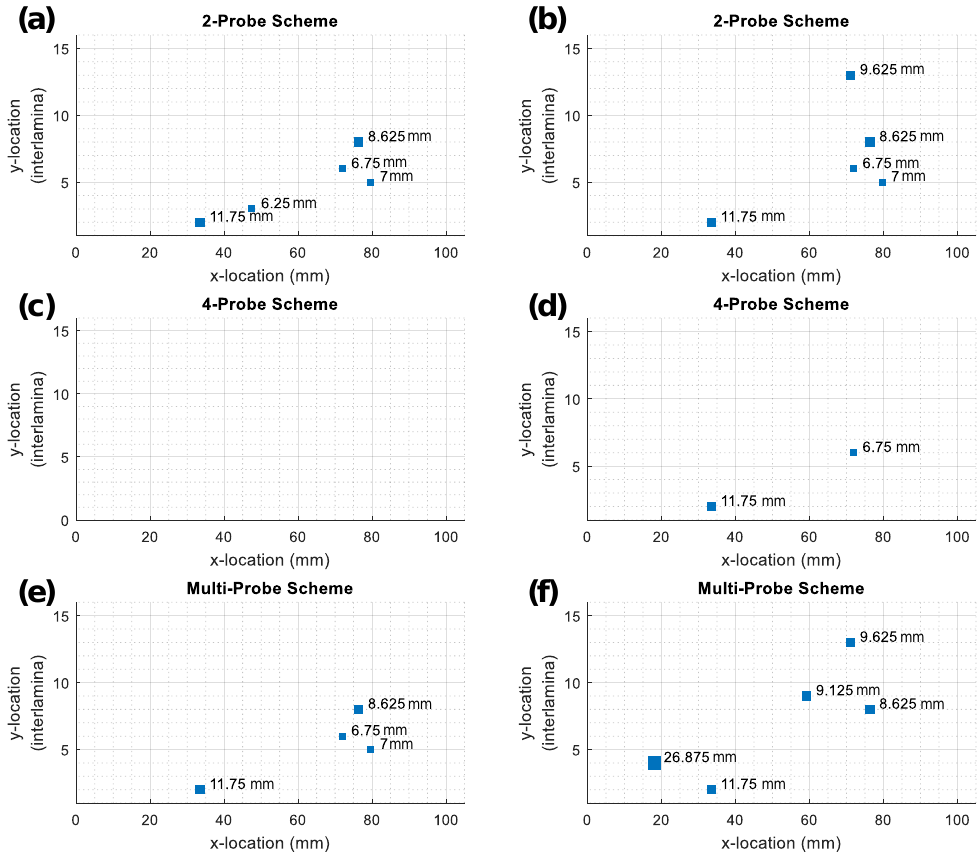
Figure 11. Failed damage cases for [ 0 4 /90 4 ] s with two-sided electrodes and: ( a ) two-probe scheme and full set of responses; ( b ) two-probe scheme and reduced set of responses; ( c ) four-probe scheme and full set of responses; ( d ) four-probe scheme and reduced set of responses; ( e ) multi-probe scheme and full set of responses; ( f ) multi-probe scheme and reduced set of responses. Crack size is shown next to the case